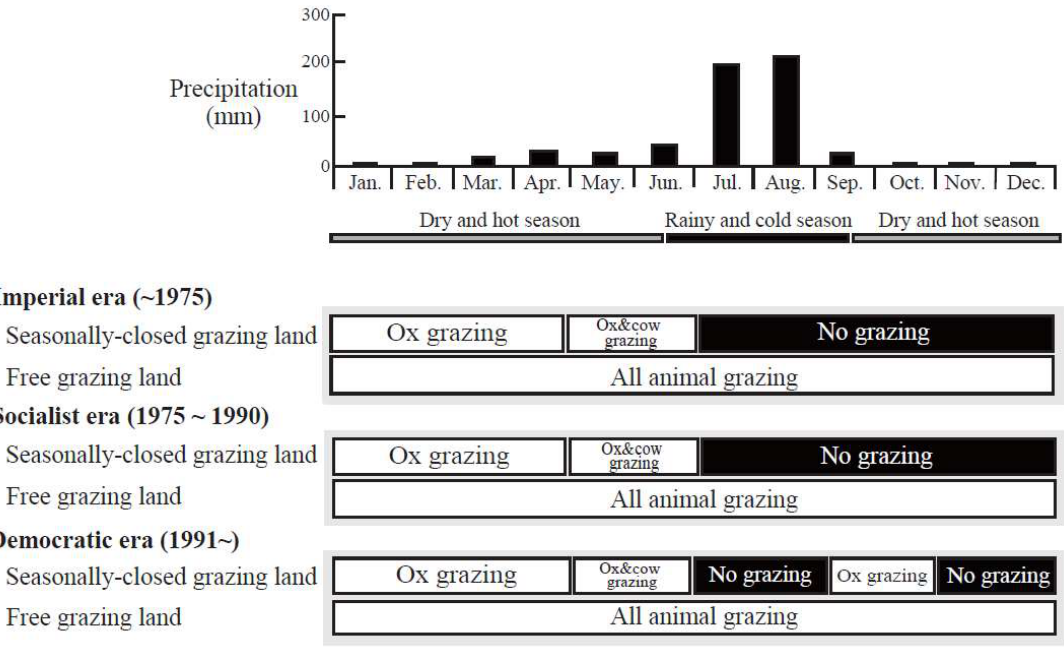
Figure 3. Changes of grazing management in the Adi Zaboy watershed (Modified from [22]).